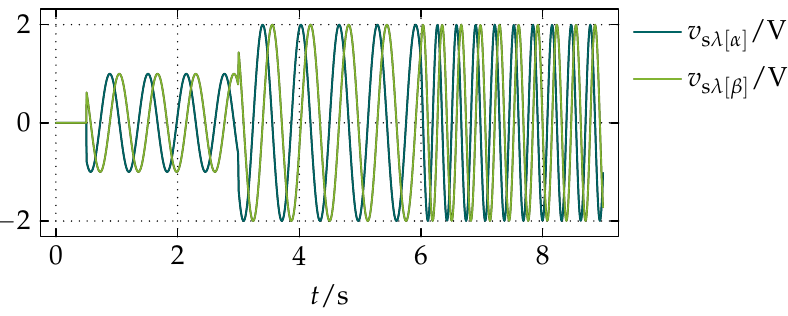
Figure 6. The reference waveforms of v s λ [ α ] and v s λ [ β ] used as test signals for